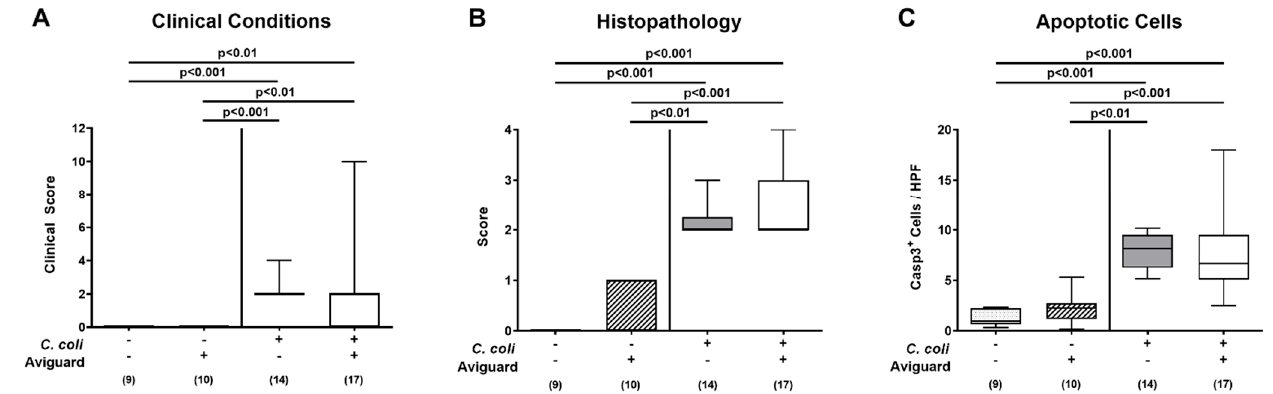
Figure 4. Clinical conditions, histopathological and apoptotic epithelial cell responses in the colon following peroral Aviguard ® treatment of C. coli -infected secondary abiotic IL-10 − / − mice. Mice were infected with a C. coli patient isolate on day (d) 0 and d1 by gavage. On d2, d3 and d4 post-infection (p.i.), mice were perorally challenged with the probiotic formulation Aviguard ® (white boxes) or received placebo (gray boxes). On d6 p.i., ( A ) the clinical condition of mice were quantified applying a clinical scoring system (see methods), and ( B ) histopathological changes in the colonic mucosa and lamina propria were assessed with standardized histopathological scores. Furthermore, the average numbers of colonic epithelial ( C ) apoptotic (Casp3 + ) cells were determined microscopically from six high-power fields (HPF, 400 × magnification) per mouse in immunohistochemically stained colonic paraffin sections. The box plots indicate the 25th and 75th percentiles of the medians (bar within boxes). Total range, significance levels ( p values) calculated by the Kruskal–Wallis test and Dunn’s post-correction and numbers of analyzed mice (in parentheses) are given. Pooled data were derived from three independent experiments. +, with; − , without.